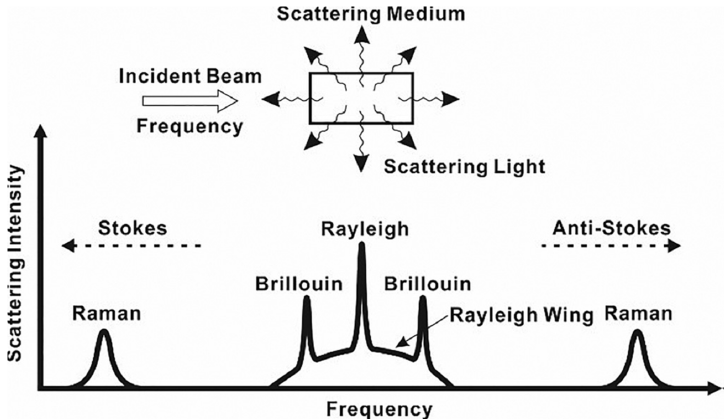
Figure 9. Light scattering spectrum with Rayleigh, Brillouin, and Raman scattering [79].